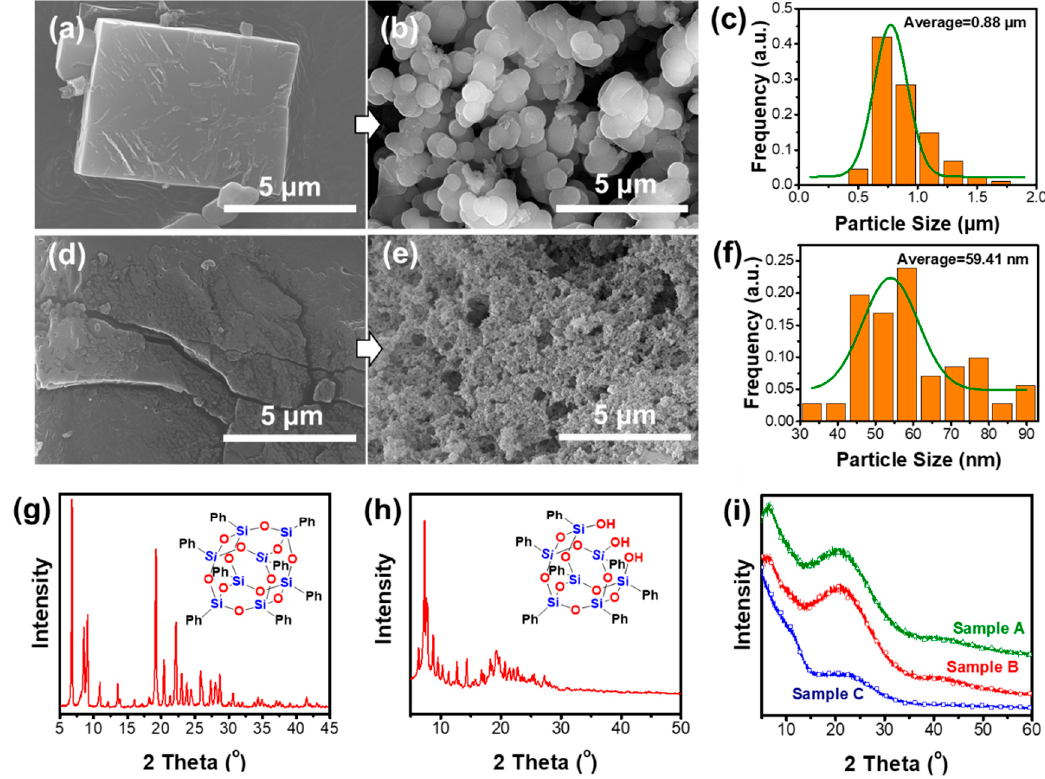
Figure 1. ( a ) Scanning electron microscopy (SEM) of original octaphenylsilsesquioxanes (OPS); ( b ) SEM of porous materials based on OPS, sample A; ( c ) particle size distribution of sample A; ( d ) SEM of original T 7 -POSS; ( e ) SEM of porous materials based on T 7 -POSS, sample C; ( f ) particle size distribution of sample C; and X-ray diffraction (XRD) curves of ( g ) OPS, ( h ) T 7 -POSS, and ( i ) the target samples. Particle size distribution is measured by Nano measurer 1.2 software based on SEM images [30].